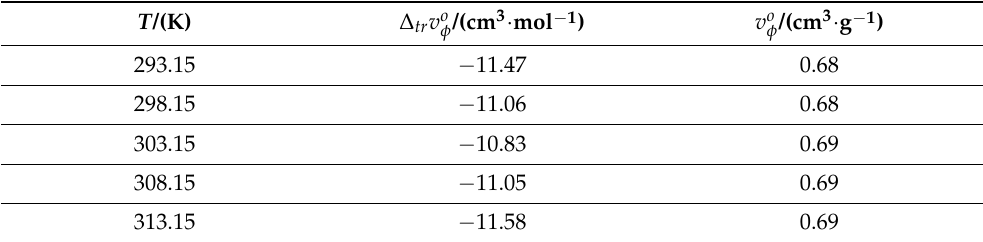
, and the apparent specific volume φ